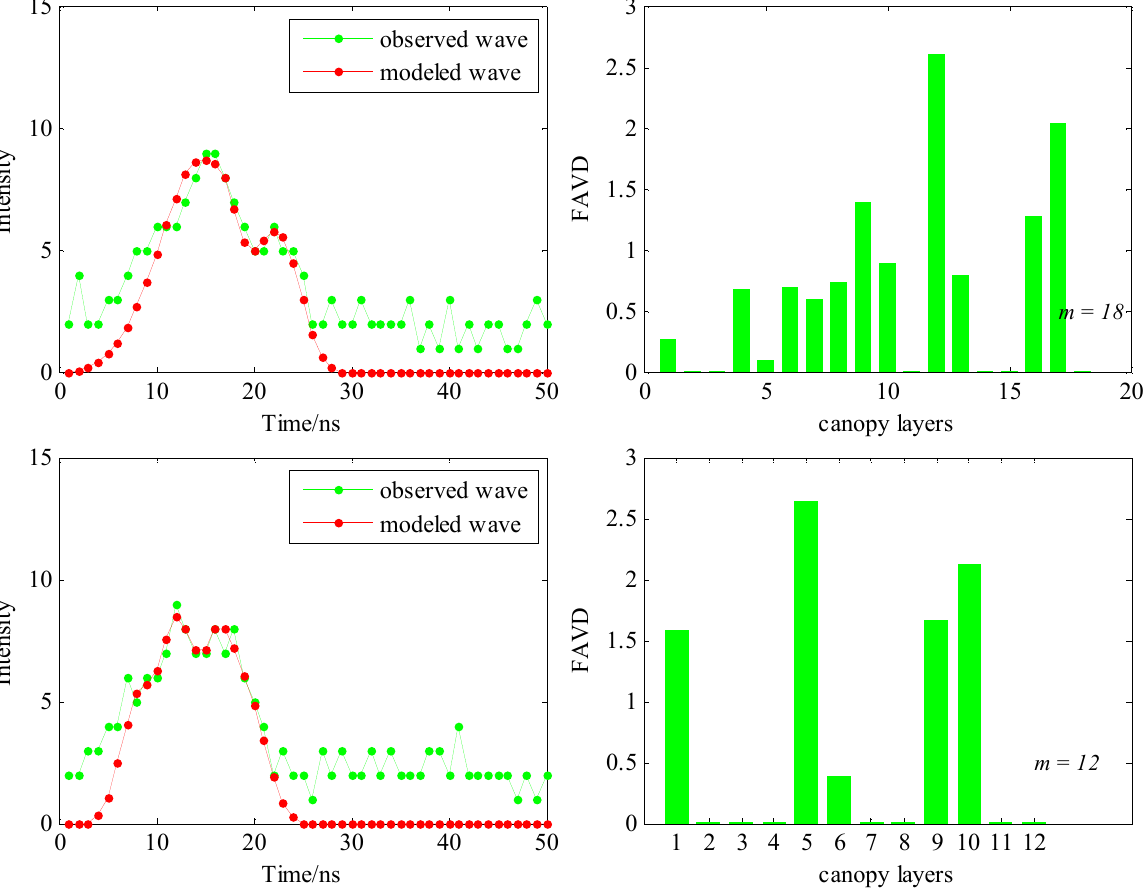
Figure 6. FAVD (Foliage Area Volume Density) inversion results of two different